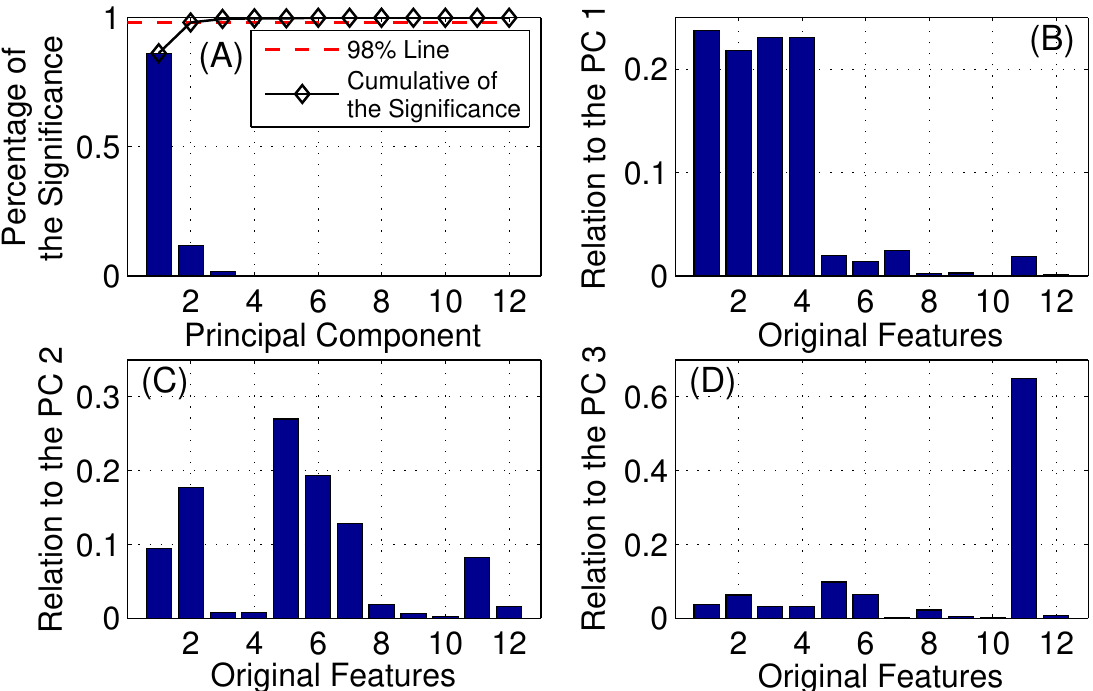
Figure 5. Example of applying principal component analysis to the feature data extracted from the training data set identified in Table 2. ( A ) Histogram of the significance of the 12 principal components, where the black diamond line represents the cumulative sum of the significance of the 12 principal components from most to least significant. ( B – D ) The relation of the original features to the first, second, and third most significant principal components